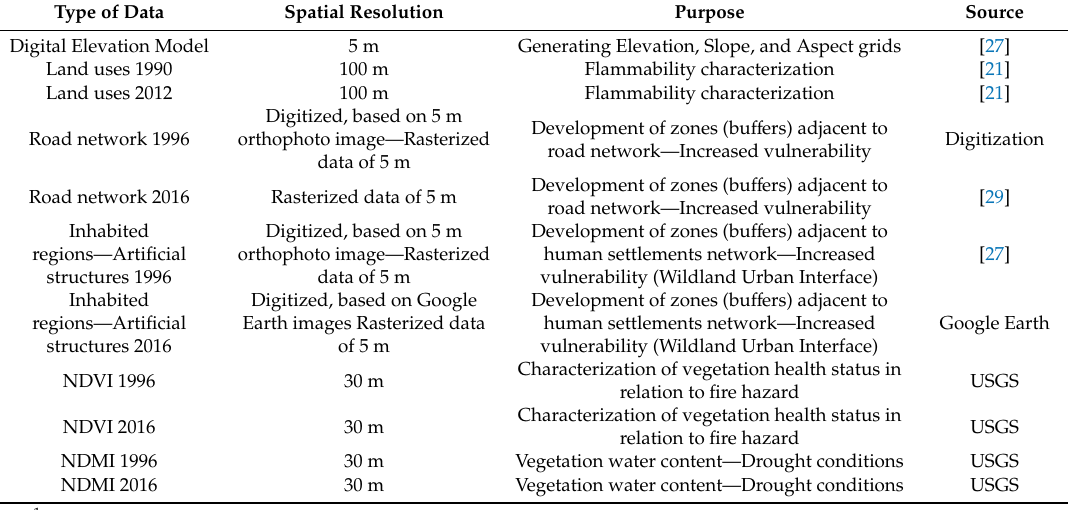
Table 1. Classification of types of data used in forest fire hazard modeling 1